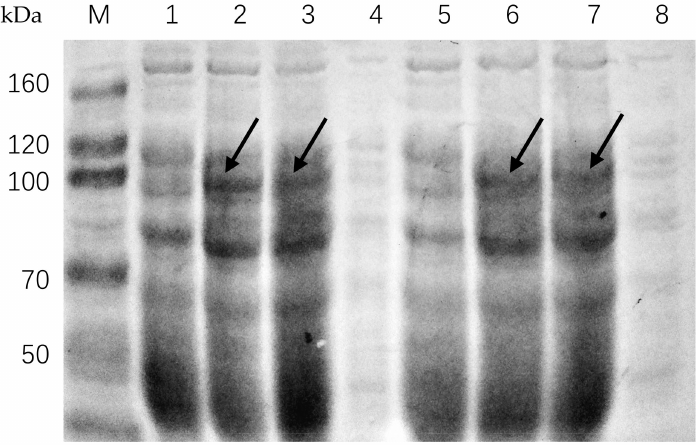
Figure 3. SDS-PAGE analysis of recombinant CsPPO1 and CsPPO2 proteins expressed in E. coli .